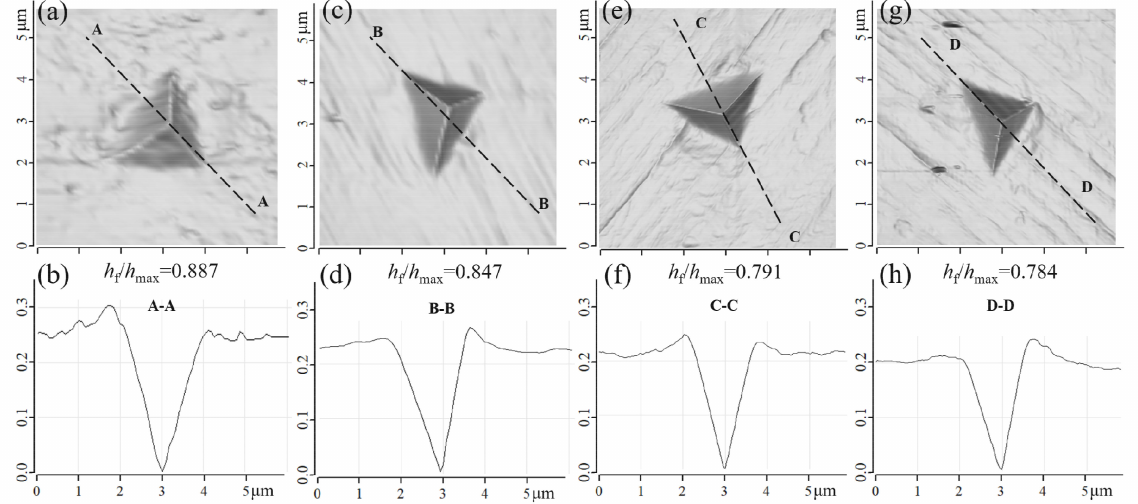
Figure 7. AFM images and corresponding surface profiles of indentations in different positions of Cu-Nb wires: ( a , b ) Cu 1 channel in 85 2 ; ( c , d ) Cu 3 +Nb region in 85 3 ; ( e , f ) Cu 3 +Cu 4 +Nb region in 85 4 ; ( g , h ) Cu 4 +Nb region in 85 4